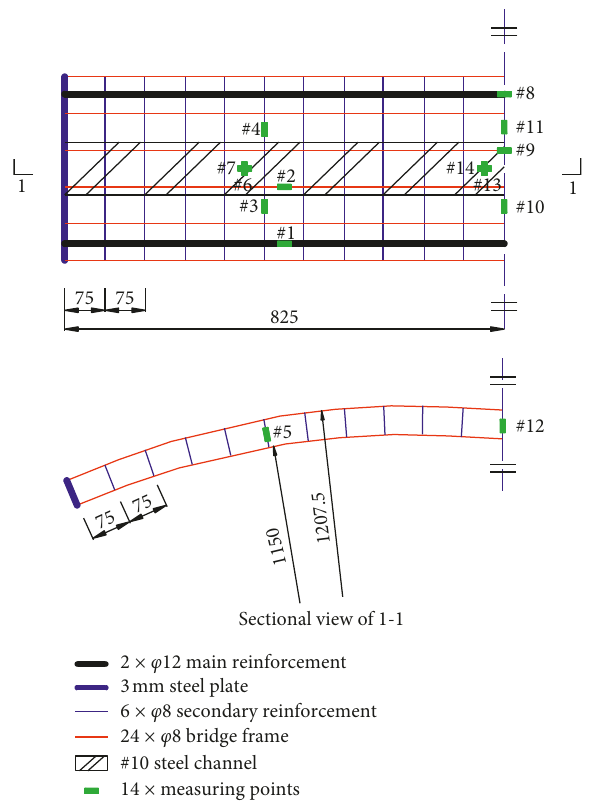
Figure 10: Arrangement of the measuring points.